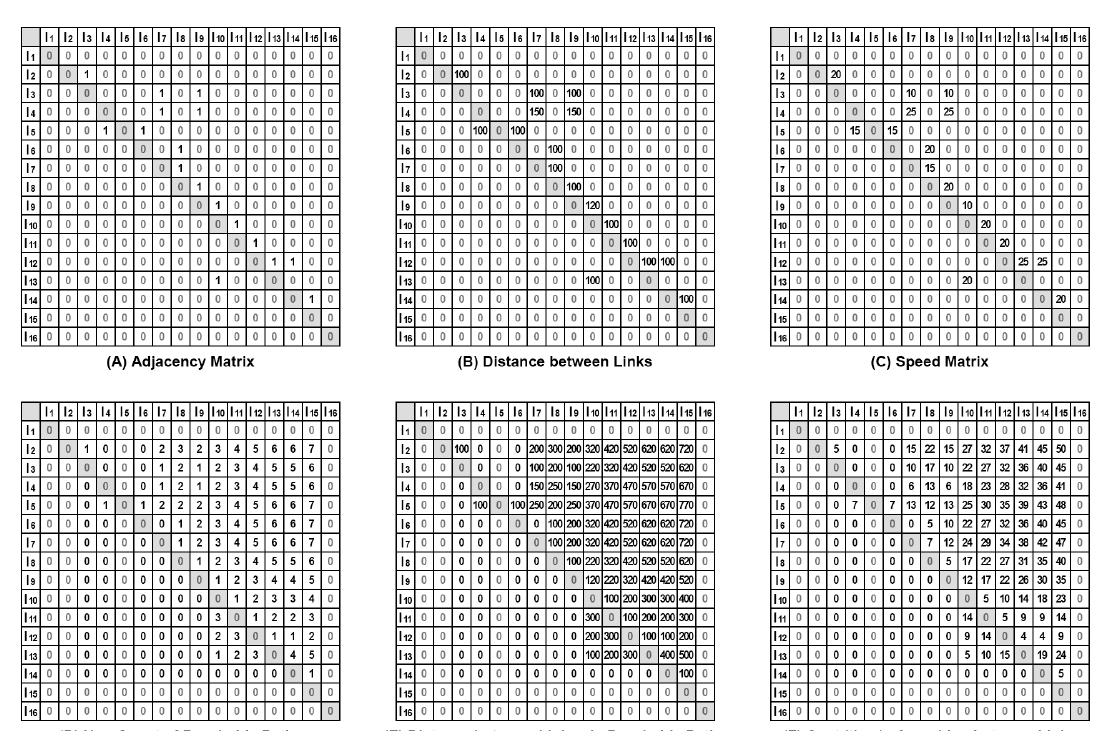
Figure 3. Matrices representing adjacency, distance, and information about reachable paths between